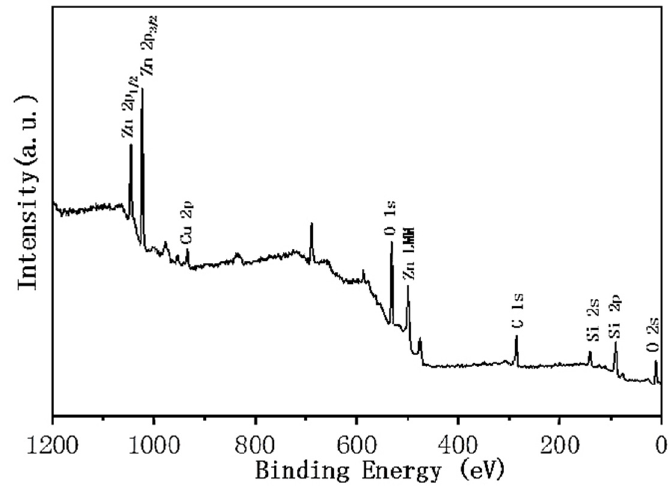
Figure 9. XPS spectrum shows four main elements: Cu, Zn, O, and C.